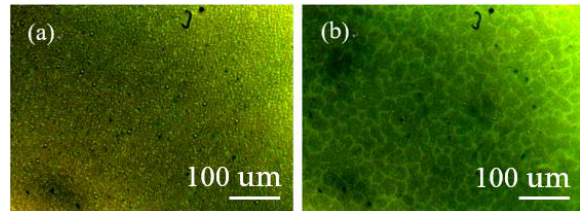
Figure 7. The surface morphology of ( a ) PS-SPLC and ( b ) T-SPLC.